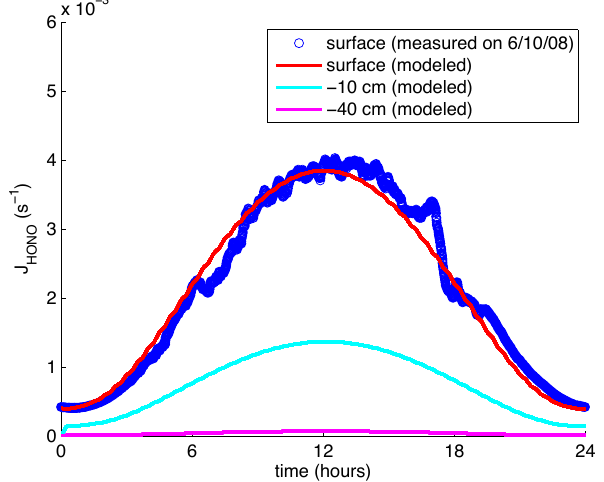
Fig. 5. Model predicted J HONO on 10 June 2008 compared to the measured J HONO . The excellent agreement between ambient and measured J HONO indicates that the rate of HONO loss in the bound- ary layer due to photolysis is correctly represented in the model. At the surface at solar noon the HONO lifetime is 4.4min, resulting in rapid photolysis to form NO and OH.